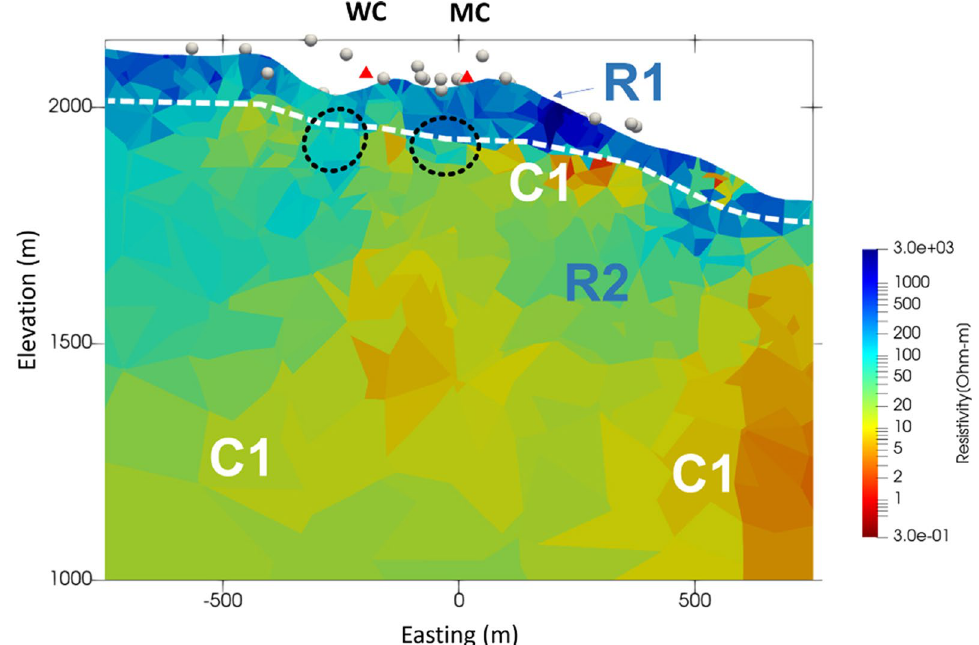
Fig. 8 East–west vertical cross-section across the Kagamiike-kita Crater of the optimal 3-D resistivity model. The red triangles represent the craters of the 2018 eruption (MC and WC). Labels indicating the resistivity features are the same as in Fig. 5. The white dashed line indicates the interpreted boundary of the basement rock. In the areas indicated by the black dotted circles, it is suggested that C1 beneath the surface resistive layer was missing due to the eruption. A possible fluid reservoir is indicated by